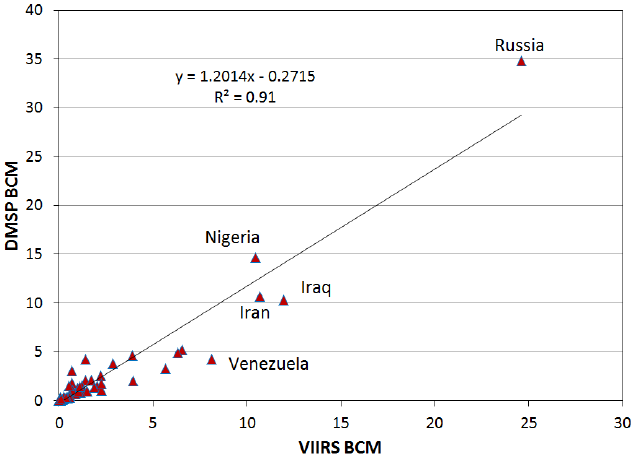
Figure 14. VIIRS versus DMSP flared gas estimates for 2012.